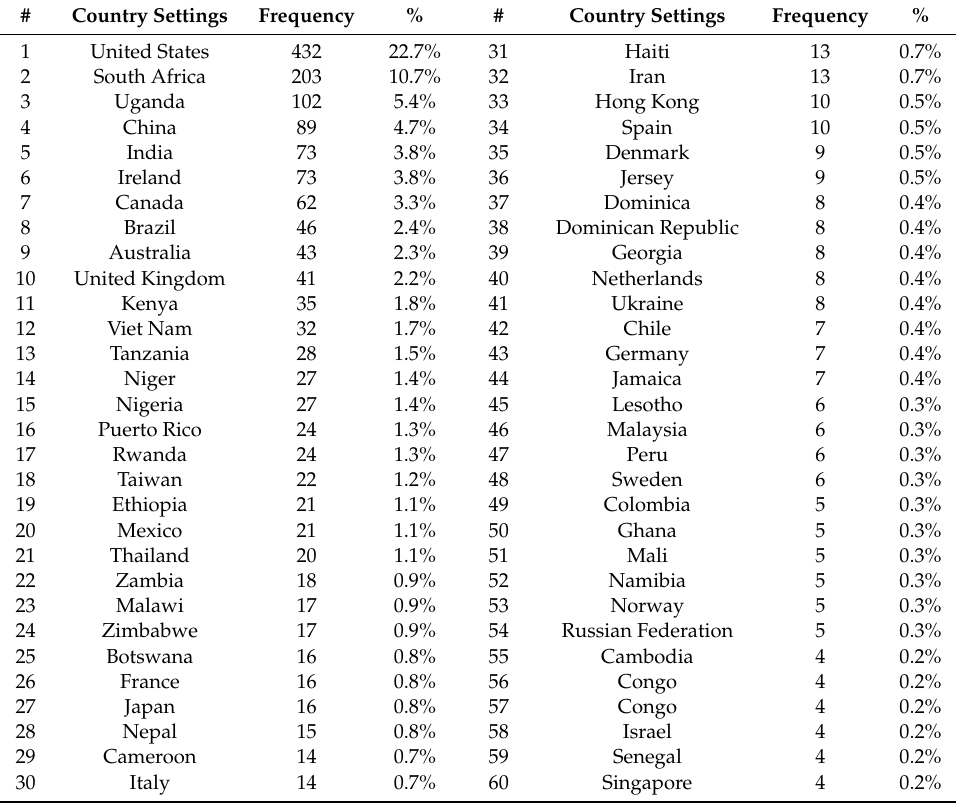
Table 2. Number of papers by countries as study